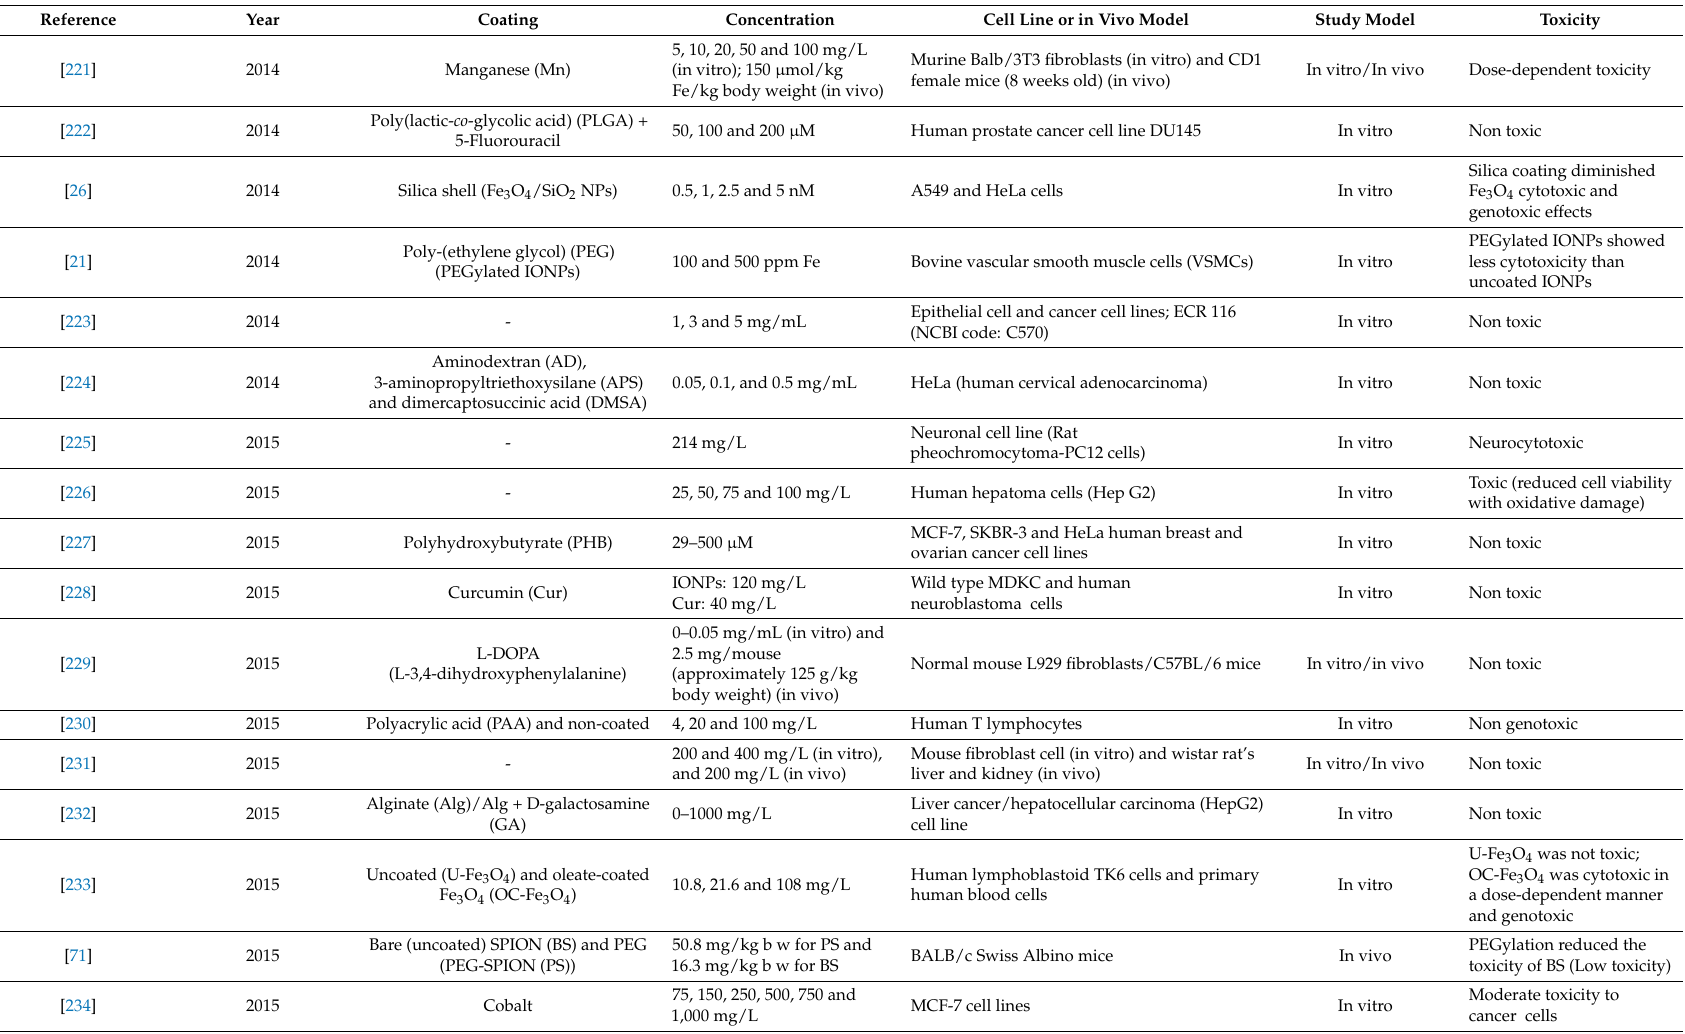
Table 1. Summary of studies assessing the toxicity of iron oxide magnetic nanoparticles (IONPs) carried out between 2014 and